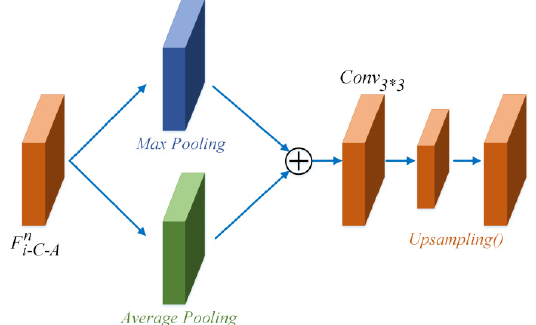
Figure 8. S-A module